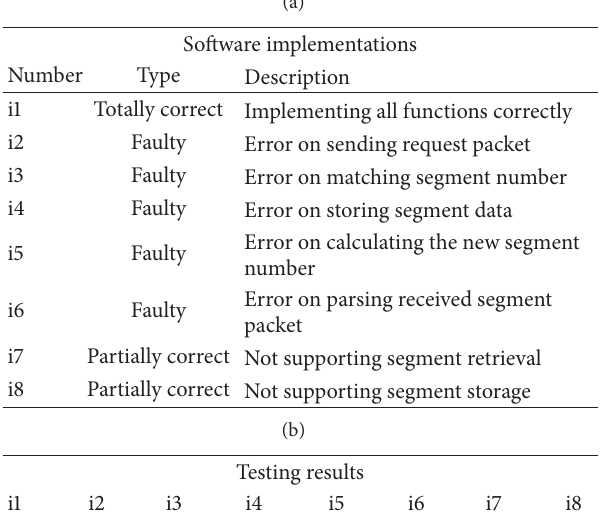
Table 1: System implementations and test